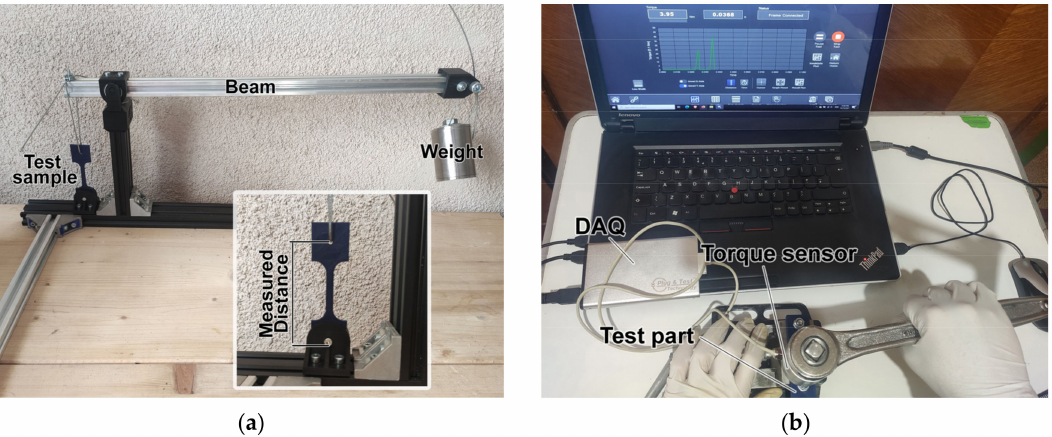
Figure 2. Creep properties testing: ( a ) Tension creep testing rig set at 9.4 × mechanical advantage and with 1250-g weight; ( b ) Compression creep testing: tightening to standard